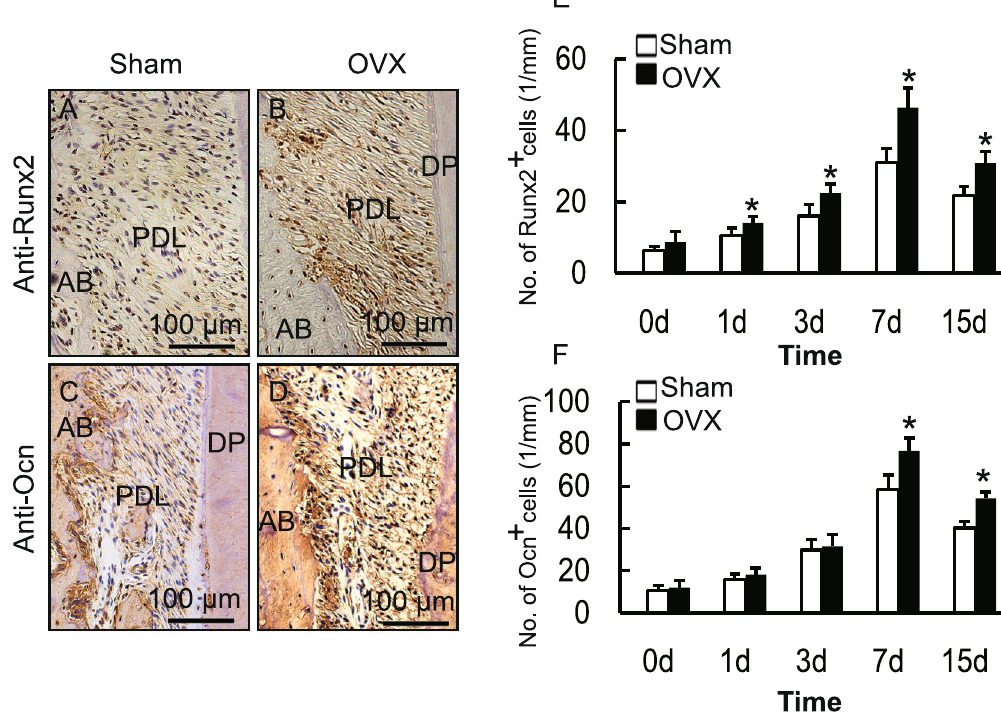
day 7 of OTM in Sham and OVX rats. ( E , F ) Number of Runx2- or osteocalcin-positive cells in the tension area during OTM. Data represent means ± S.D. * P < 0.05, n =